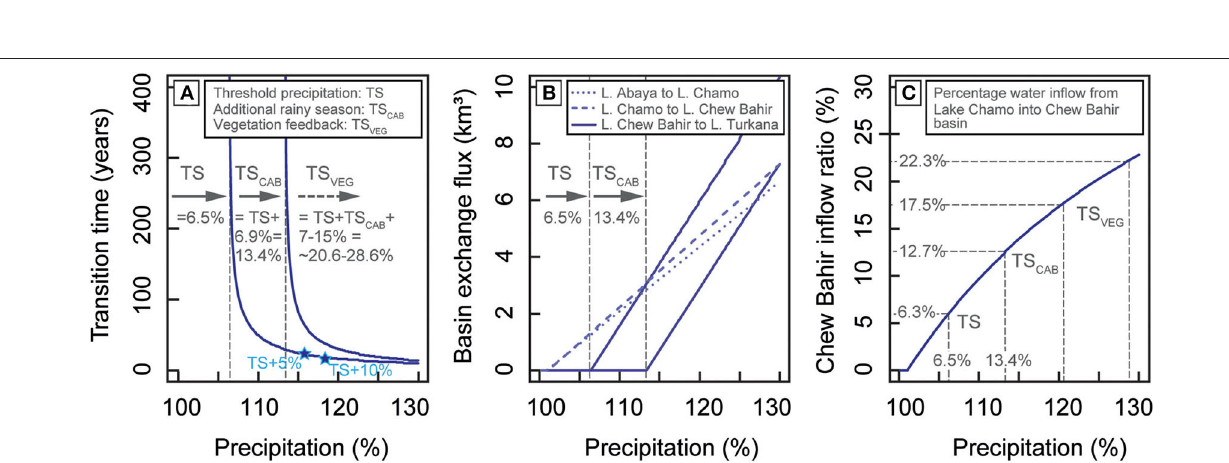
FIGURE 5 | The effects of precipitation increase on the investigated lake basins: (A) Transition times of paleo-lake Chew Bahir from “no lake” to “overflowing lake” into Lake Turkana under minimum threshold (TS) conditions where seasonality has not changed; under the consideration of an additional rainy season caused by a shift of the location of the Congo Air Boundary (TS CAB ); and the incorporation of theoretically vegetation feedback (TS VEG ) with values taken from Bergner et al. (2003), since no local paleo-data are available. The graph shows the increasing pace of lake level rise with increasing precipitation. (B) Water mass exchange between the three investigated basins for the scenarios, TS and TS CAB . (C) Precipitation and overflowing Lake Chamo-Abaya as relative water sources of paleo-lake Chew Bahir showing the importance of an enlarged catchment of Chew Bahir during overflow times of all lakes. Whereas, under TS conditions Chew Bahir inflow ratio is at 6.3%, the inflow doubles up to 12.7% when considering an additional rainy